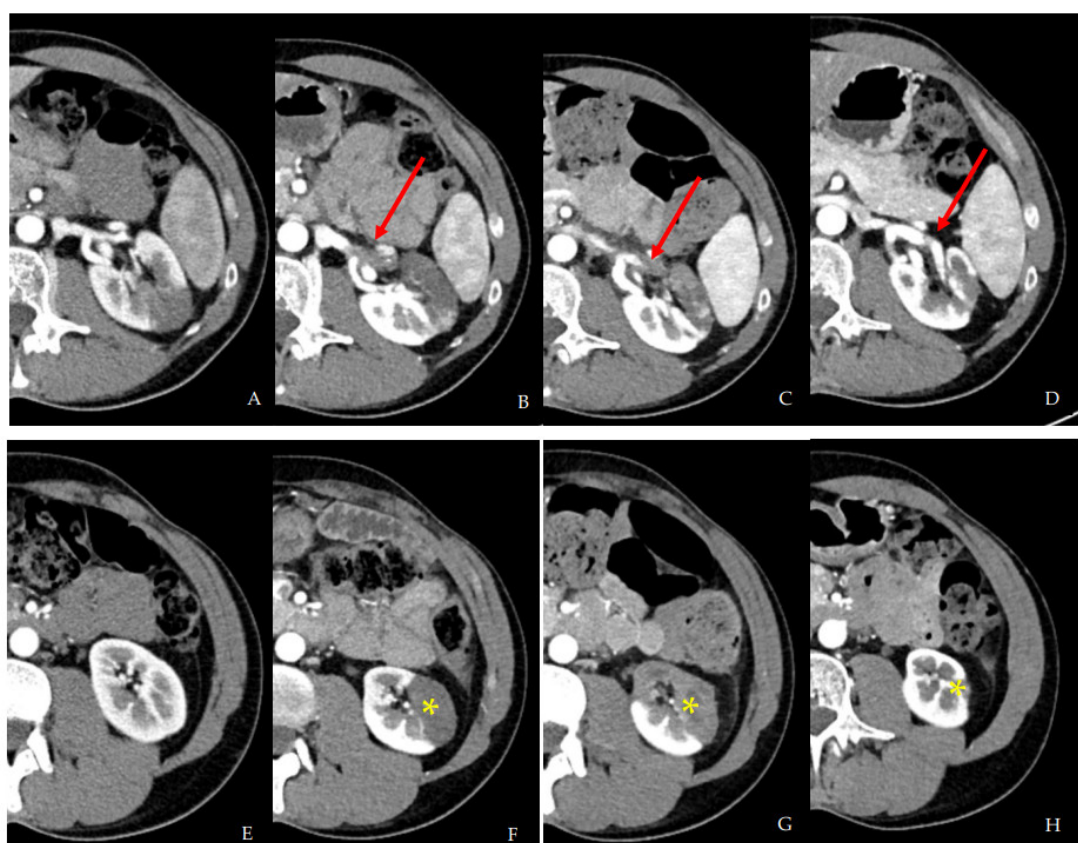
Figure 2. ( A ) shows first CT scan on first admission. ( B – D ) (red arrows) show thrombosis of one of the two branches of left renal artery at second hospital admission ( B ), after 7 days ( C ), and after